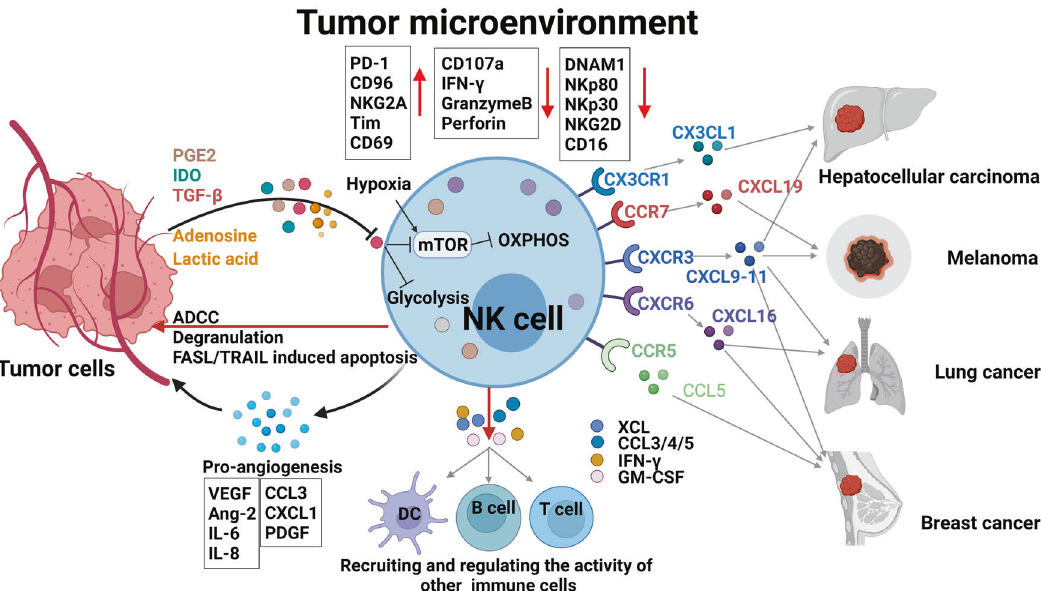
Fig. 4 NK cells in the TME. NK cells extravasate from the blood, traverse the ECM and tumor stroma, and reach the tumor bed when they are recruited by integrin, chemokine receptor, and selectin. In the TME, NK cells eliminate tumor via degranulation, ADCC, or FASL/TRAIL-induced apoptosis. NK cells can also secrete cytokines or chemokines to recruit other immune cells and upregulate the anti-tumor response. However, NK cell responsiveness is often hindered by repressive factors secreted by tumor cells or other cells or by direct cell – cell interaction. In addition, NK cells can be educated by tumor cells, for example, to secrete pro-angiogenic factors to promote tumor angiogenesis. This education can switch anti-tumor immunity to pro-tumor immunity in the TME. Created with